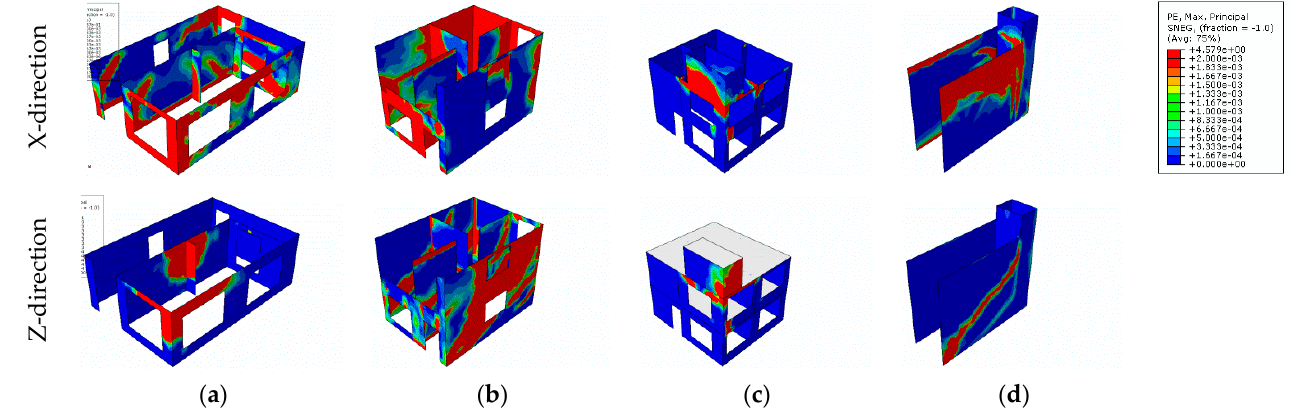
Figure 9. Maximum principal plastic strains (associated with tensile cracks) of the URM models at the end of analyses: ( a ) Type − 1; ( b ) Type − 2; ( c ) Type − 3; ( d ) Type −